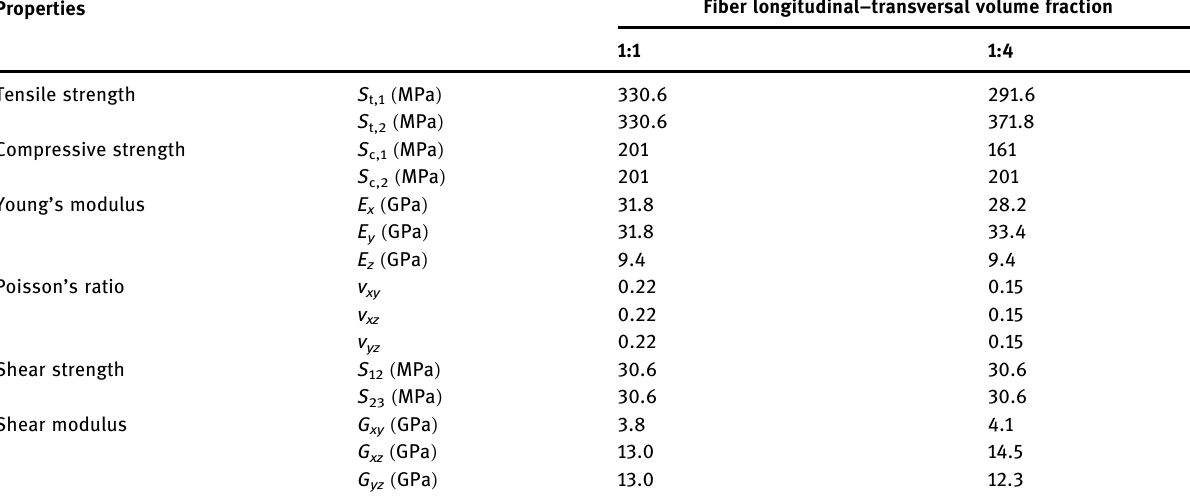
Fiber longitudinal – transversal volume fractionProperties